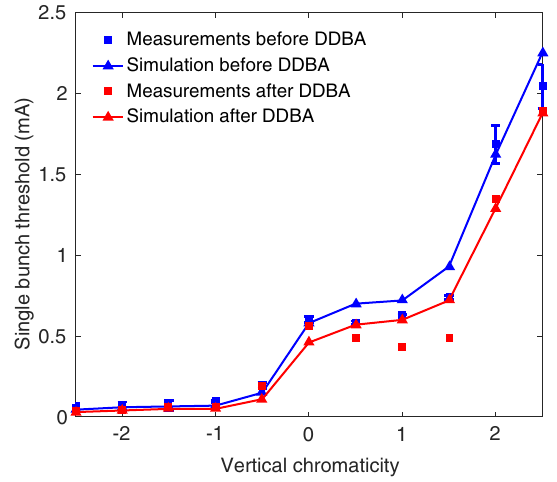
FIG. 12. Vertical instability thresholds as a function of